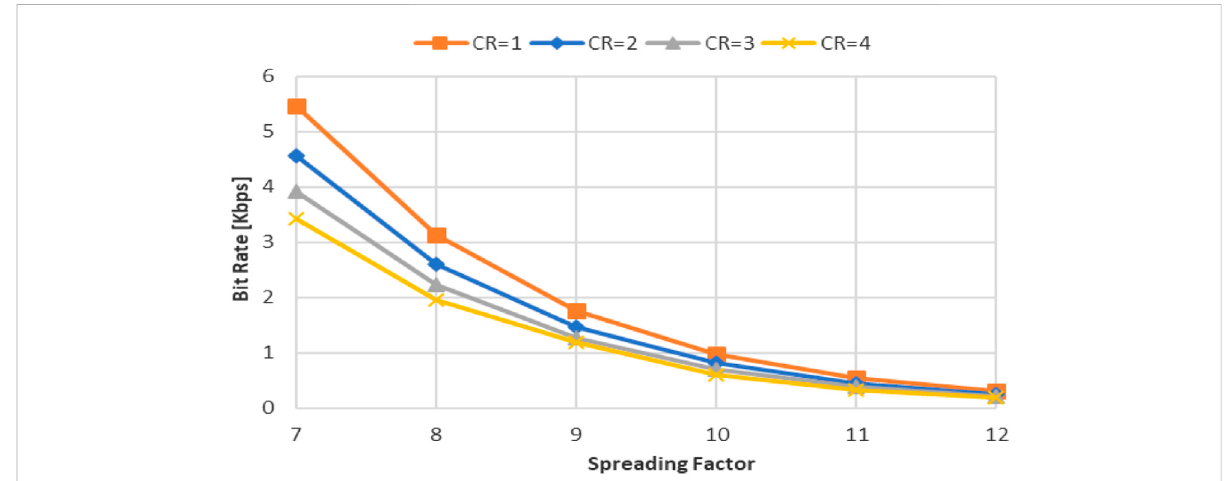
FIGURE 14 Calculated LoRa throughput.